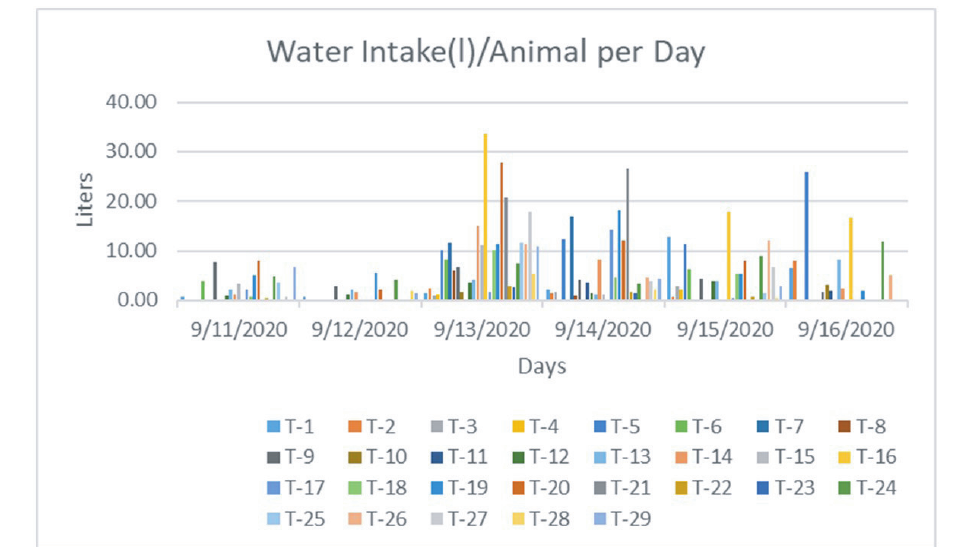
Figure 13. Recorded water intake data by each individual cow.